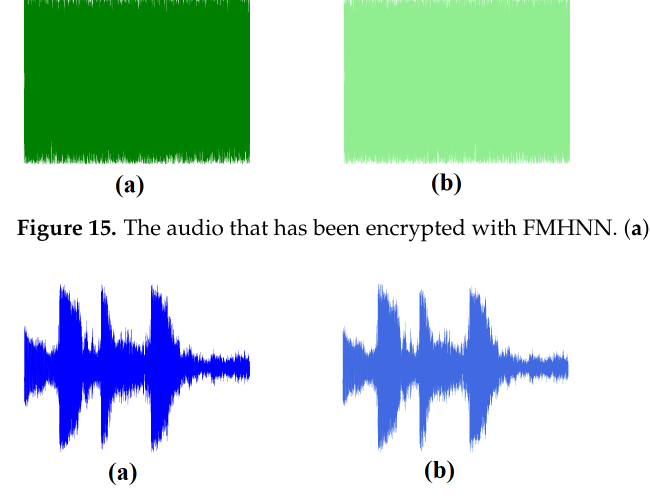
Figure 16. The audio decrypted by Topic “KEY”. ( a ) left channel, ( b ) right channel. Table 3. Comparison with previous